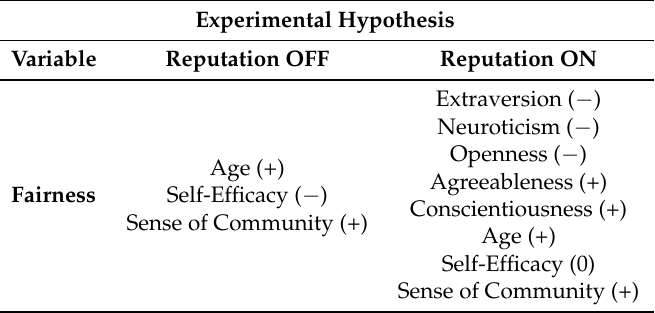
Table 1. Summary of the experimental hypothesis. The table reports the literature predictions on the socio-demographic and psychological antecedents of fairness when a reputational system is (or is not) involved in the game context. Experimental Hypothesis Variable Reputation OFF Reputation ON Extraversion ( − ) Neuroticism ( − ) Openness ( − ) Age (+) Agreeableness (+) Fairness Self-Efficacy ( − ) Conscientiousness (+) Sense of Community (+) Age (+) Self-Efficacy (0) Sense of Community